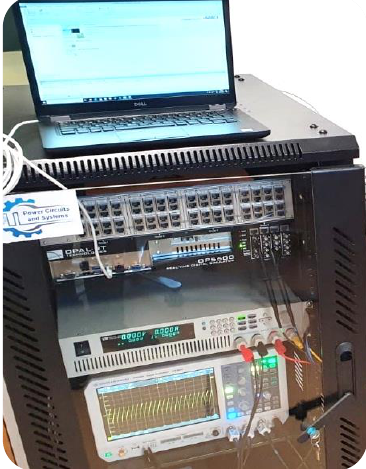
Figure 7. Photograph of the OPAL-RT setup adopted for the HiL verification. To analyze the performance of the proposed dc-dc boost converter, the operating mode of the converter must first be determined. According to (23) and Table 3, the value of critical inductances for are equal to 256 H . If converter will be in CCM; otherwise, it will be in DCM. The operation of the proposed . The experimental results are rec- . The switch ’ s current waveforms are il-